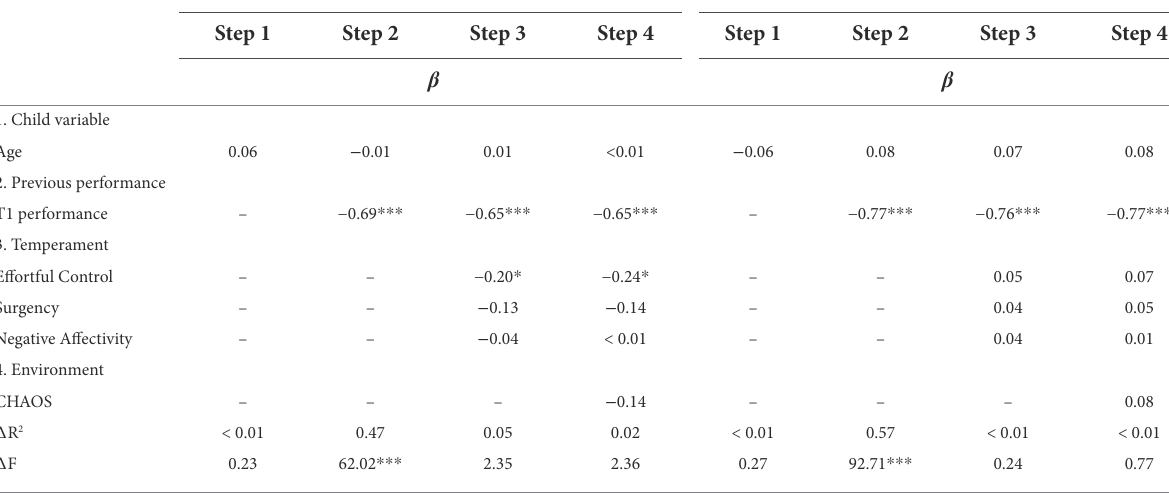
TABLE 9 Regression coefficients for change between Time 1 and Time 2 for correct anticipations.